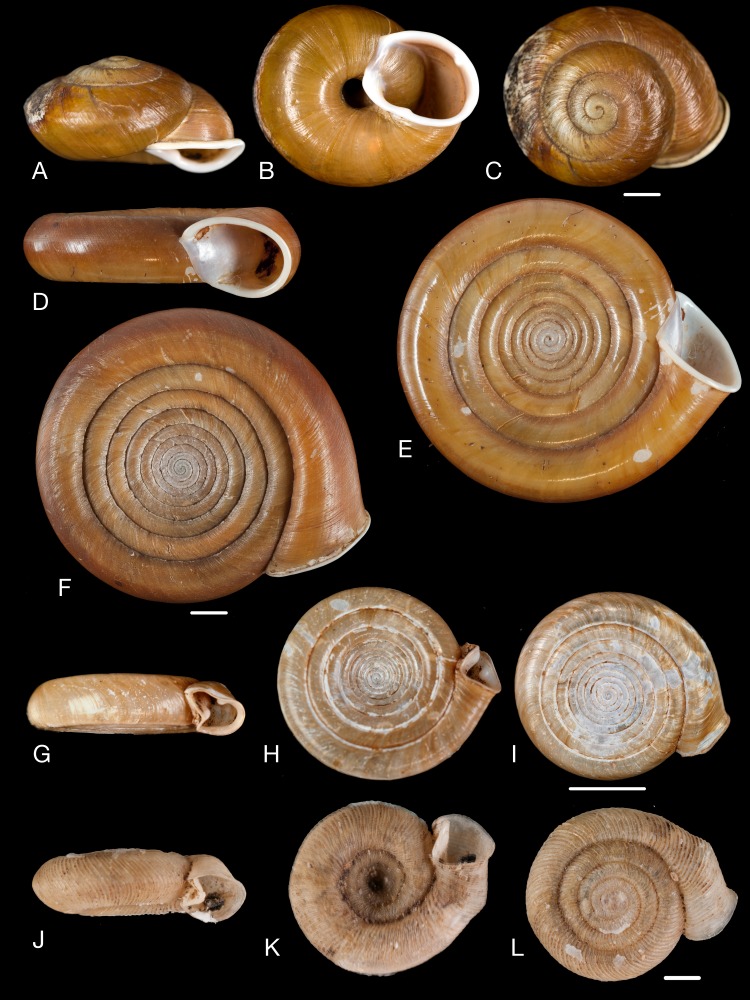
Material collected by the CCP.(A–L) Pleurodontidae. Isomeria morula (Hidalgo, 1870), MNCN 15.05/60012, (A) ventral view, (B) umbilical view, (C) apical view; Polygyratia polygyrata (Born, 1778), MNCN 15.05/14101, (D) lateral view (lip), (E) umbilical view, (F) apical view;  Polygyratia heligmoida (d’Orbigny, 1835), MNCN 15.05/76238, (G) ventral view, (H) umbilical view, (I) apical view; Polygyratia reyrei (Souverbie, 1858), MNCN 15.05/76235, (J) ventral view, (K) umbilical view, (L) apical view. Scale line 1 mm (J–L), 5 mm (A–I).